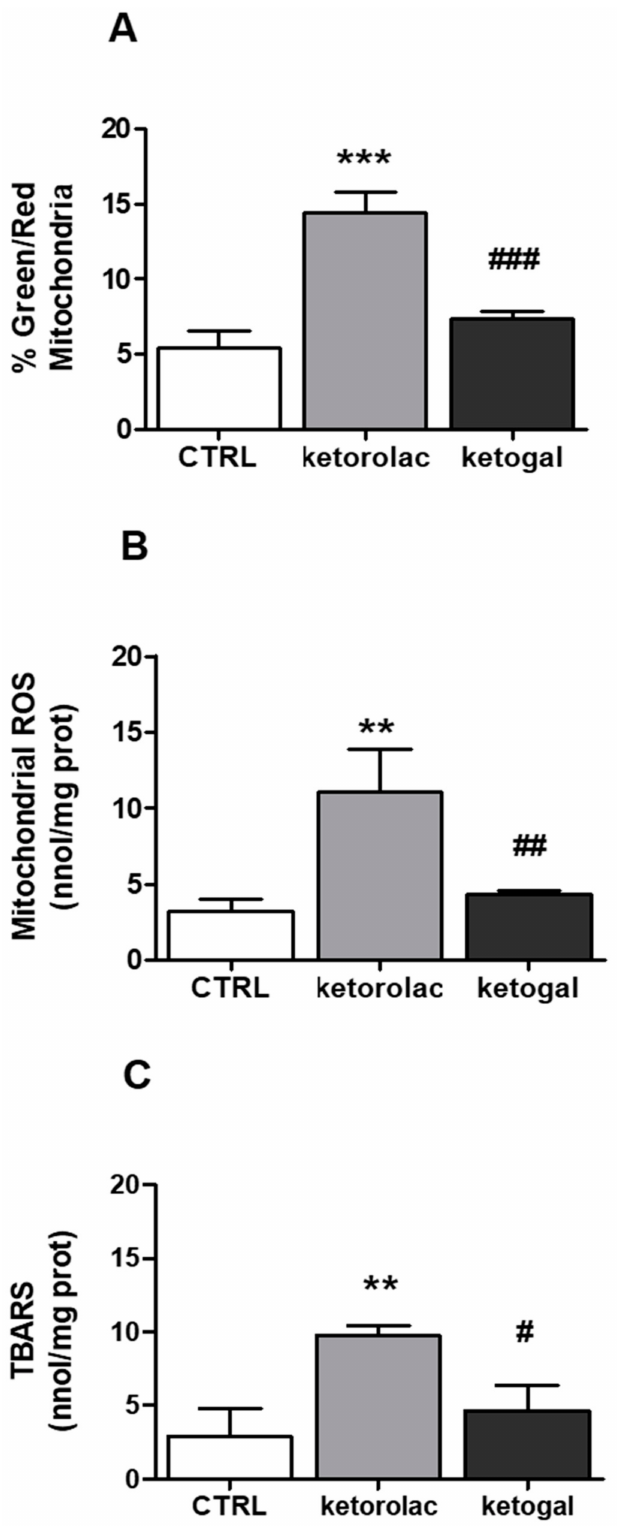
Figure 4. ( A ) Mitochondrial membrane potential was measured fluorometrically in triplicate using the JC-1 probe. Data are presented as means ± SEM (n = 3) of the percentage of green-fluorescent/red- fluorescent mitochondria. Significance of treated (ketorolac or ketogal) versus respective untreated cells: *** p < 0.001. Significance of ketogal vs. ketorolac: ### p < 0.001. ( B ) Mitochondrial ROS level was measured fluorometrically in triplicate using the MitoSOX Red probe. Data are presented as means ± SEM ( n = 3). Significance of treated (ketorolac or ketogal) versus respective untreated